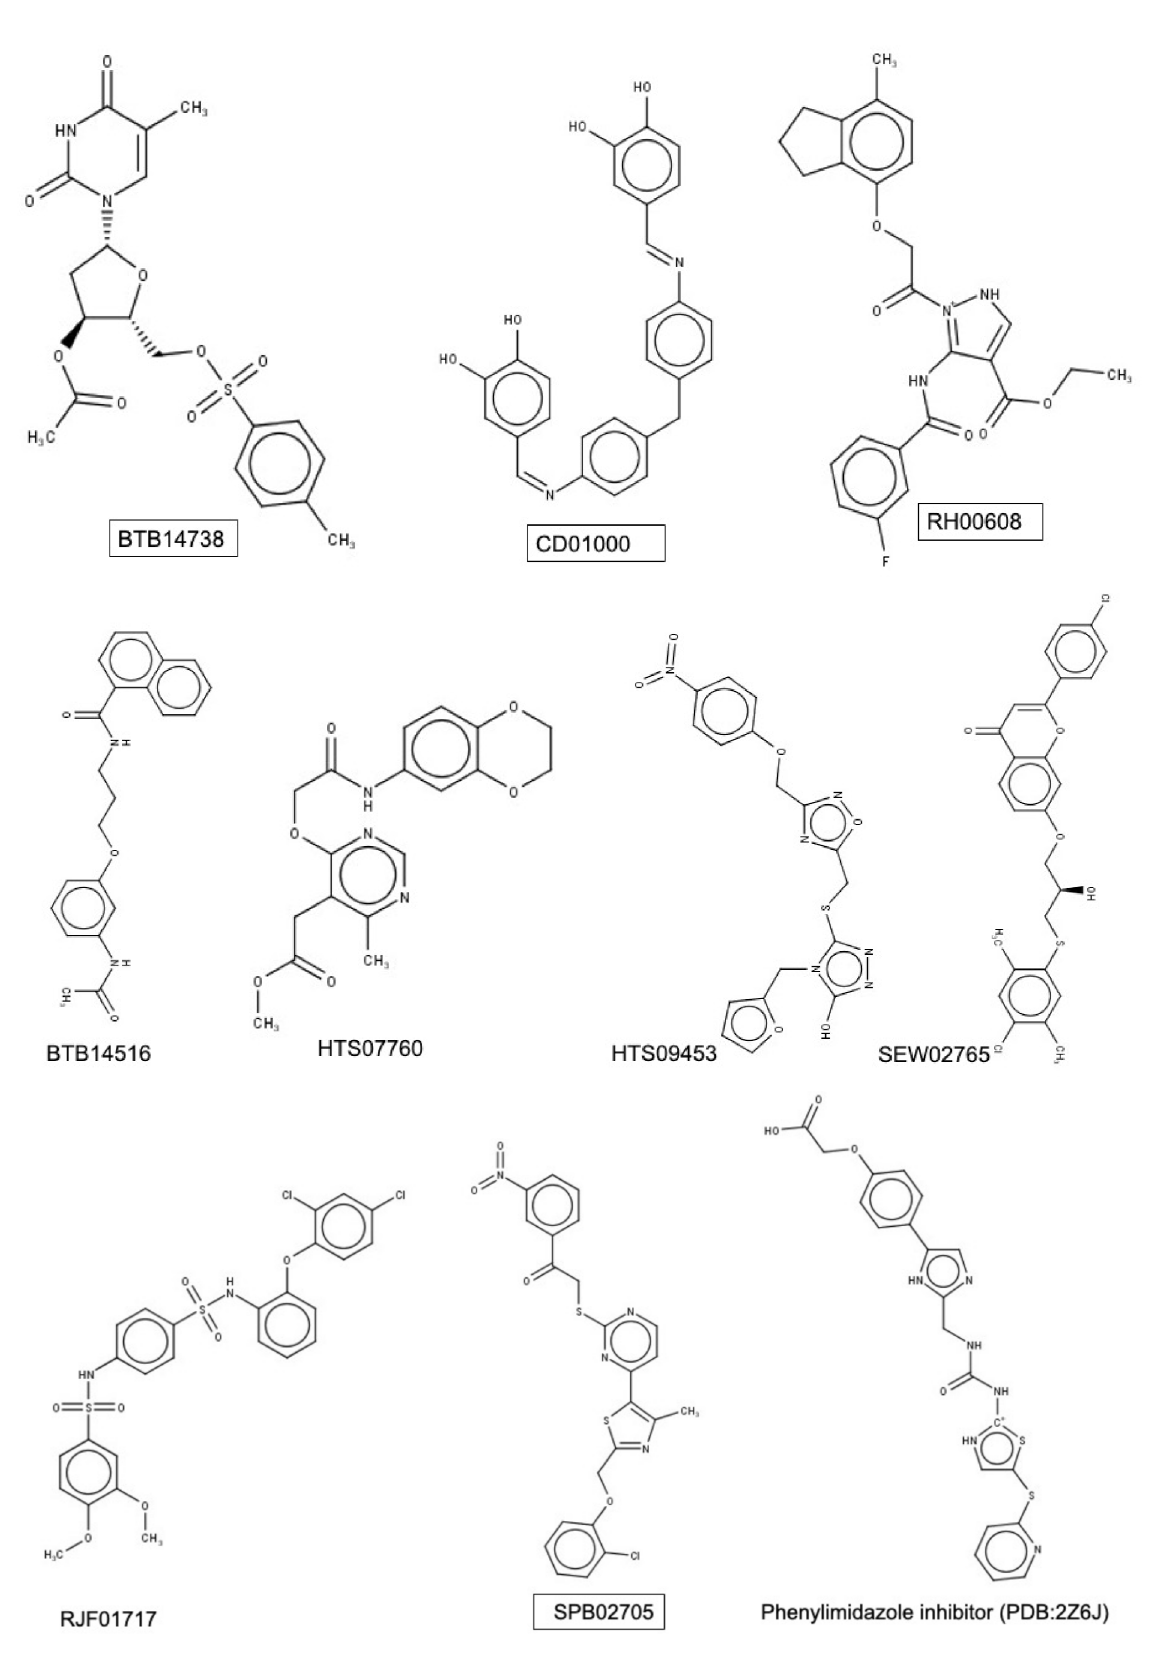
Figure 3. The structures of nine selected compounds after docking-based screening are shown along with the inhibitor of S. pneumoniae Enoyl-Acyl Carrier Protein Reductase (FabK). The labels of four putative inhibitors are highlighted in